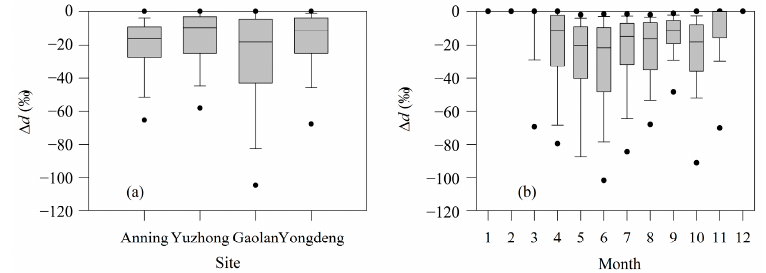
Figure 6. Regional ( a ) and monthly ( b ) variations of Δ d in precipitation.